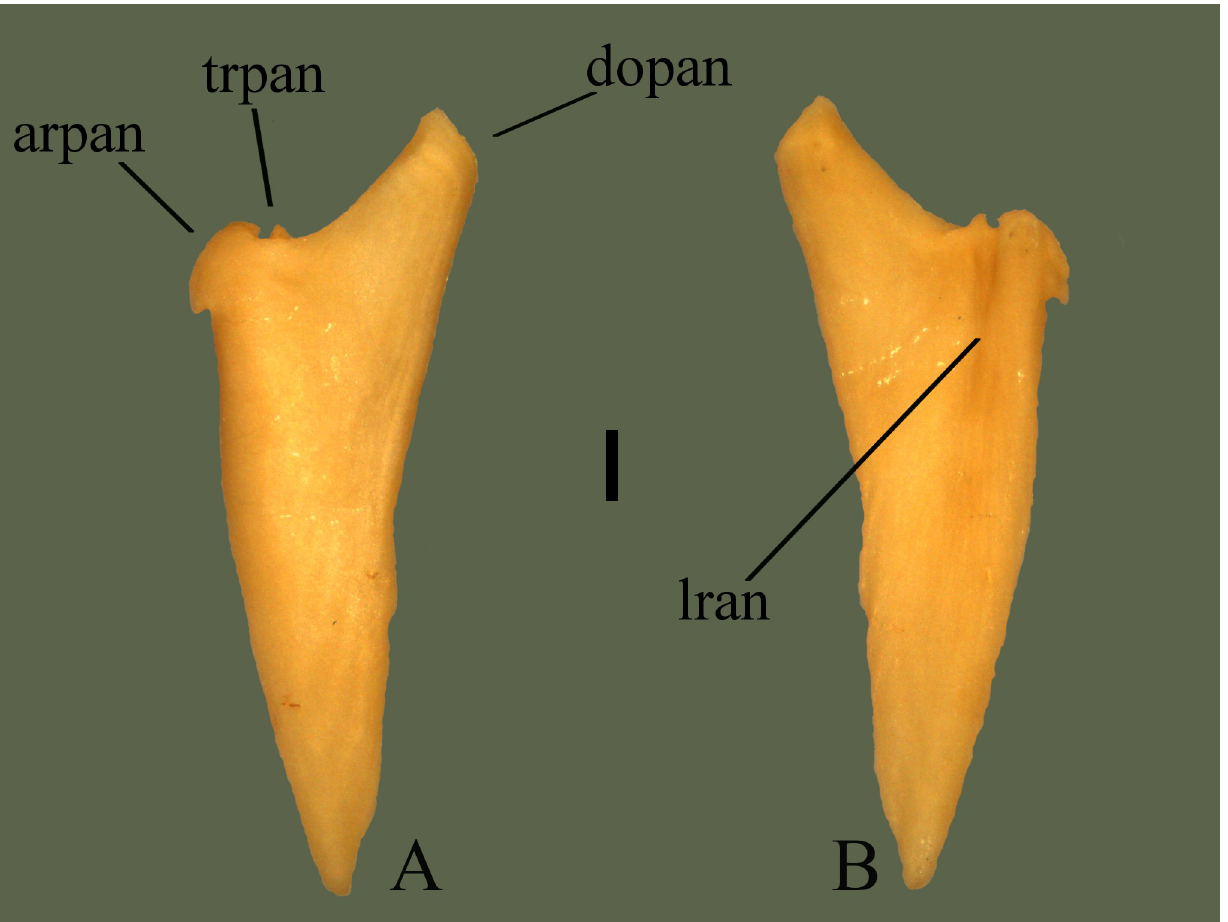
Fig 19. Right angular (ETVP 3295) in medial (A) and lateral (B) view . Anterior is to the top. Scale bar = 1 mm. Abbreviations: arpan = anterior rounded process of angular; dopan = dorsally oriented process of angular; lran = lateral ridge of angular; trpan = triangular process of